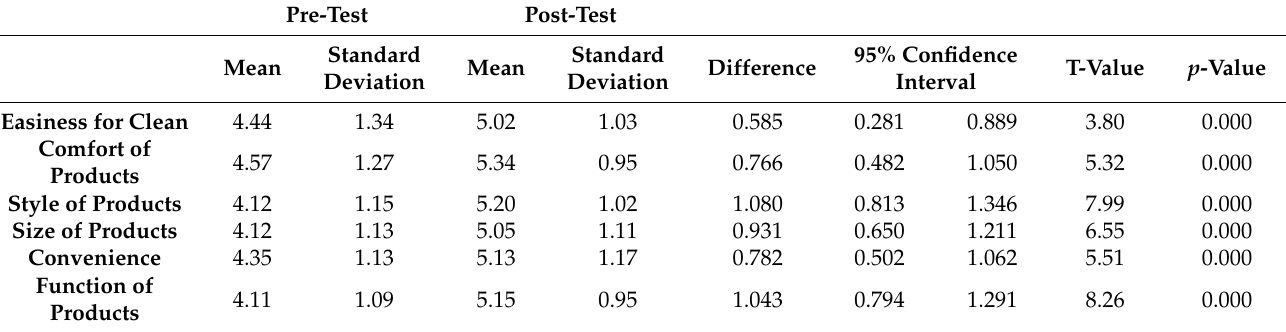
Table 2. Satisfaction level and t -test result of the trial.